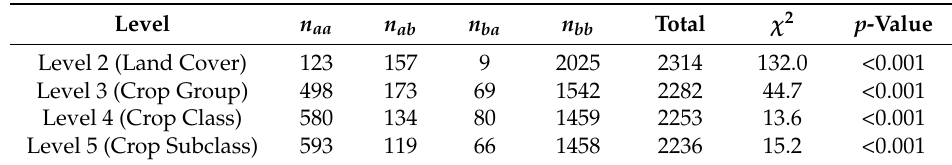
Table 6. Results of the McNemar’s test performed at each nomenclature level between the classical and hierarchical approaches.